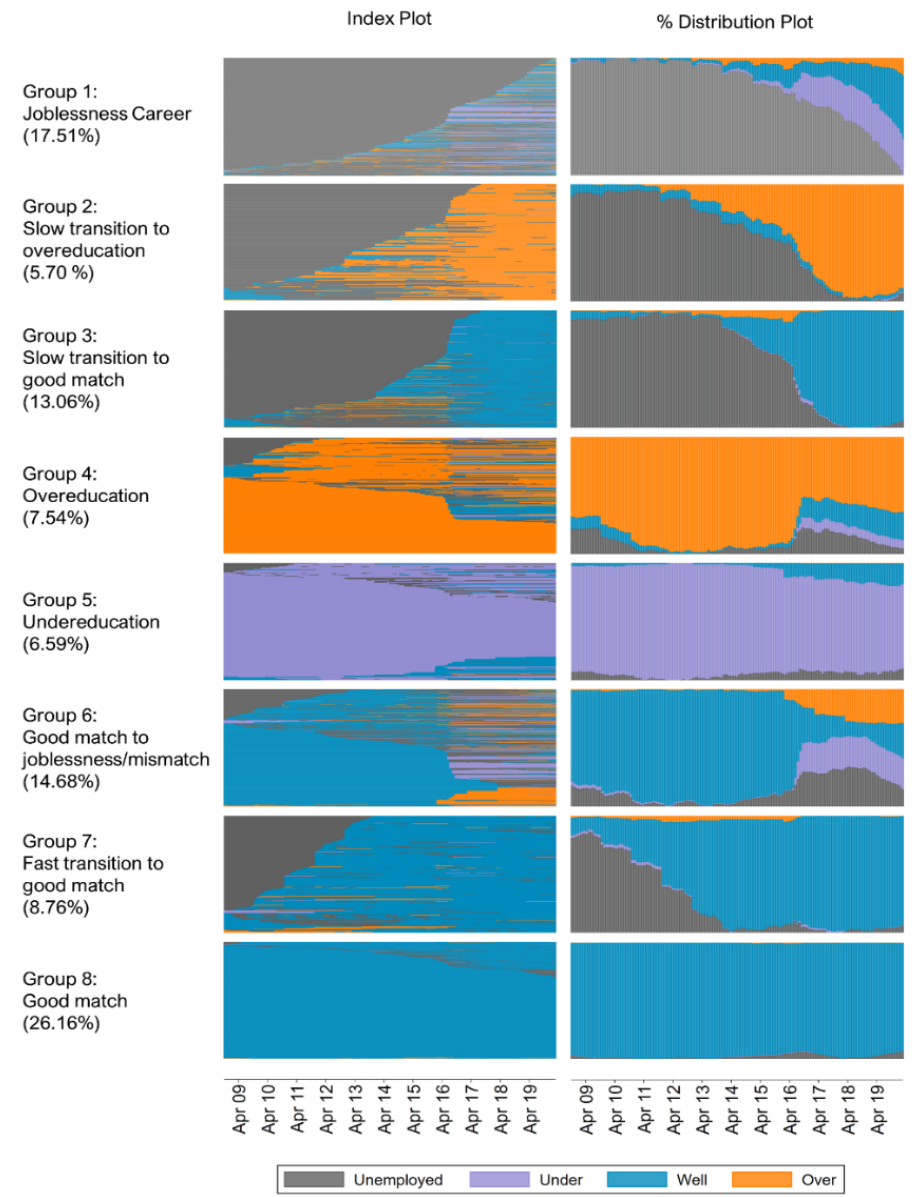
Figure 2. Sequence index and distribution plot of educational mismatch trajectory clusters, 2009– 2019.